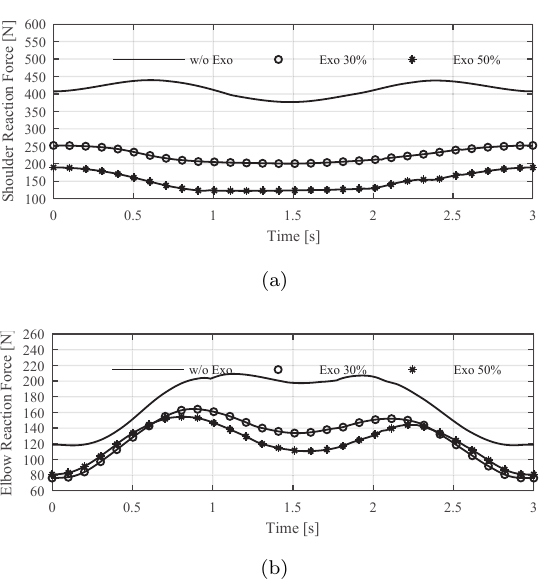
Figure 10: Magnitude of joint reaction forces in the hu- man musculoskeletal system during the bi- cep curl; (a) shoulder glenohumeral joint, (b) elbow joint